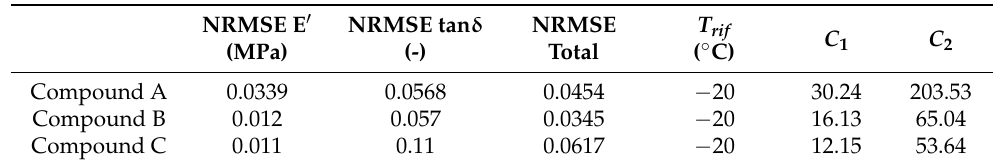
Figure 11. Example of the experimental starting set for the identification with partial DMA for com- pound C.